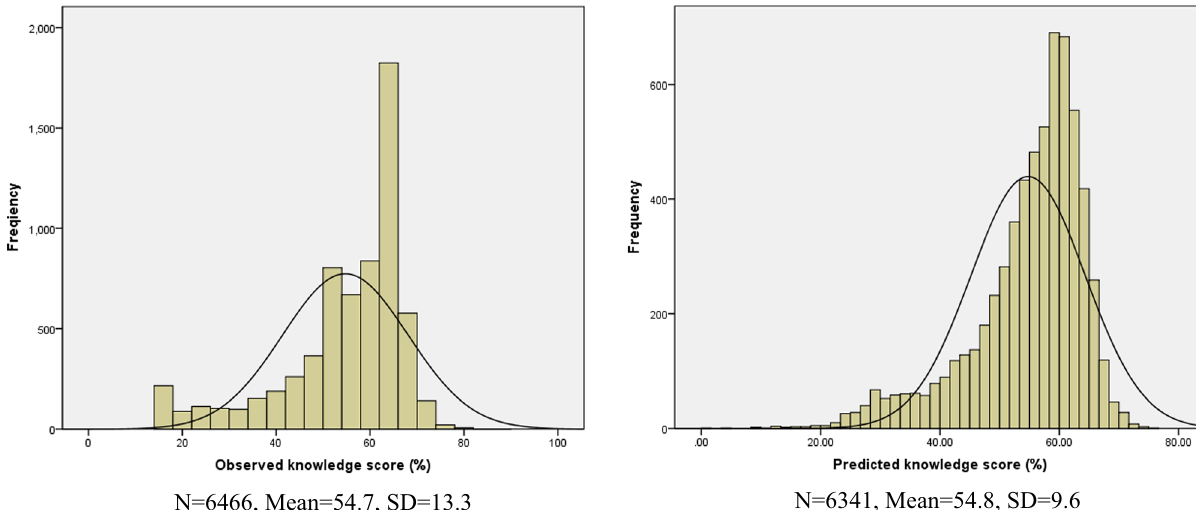
Figure 2. Distribution of observed and predicted knowledge scores (%).